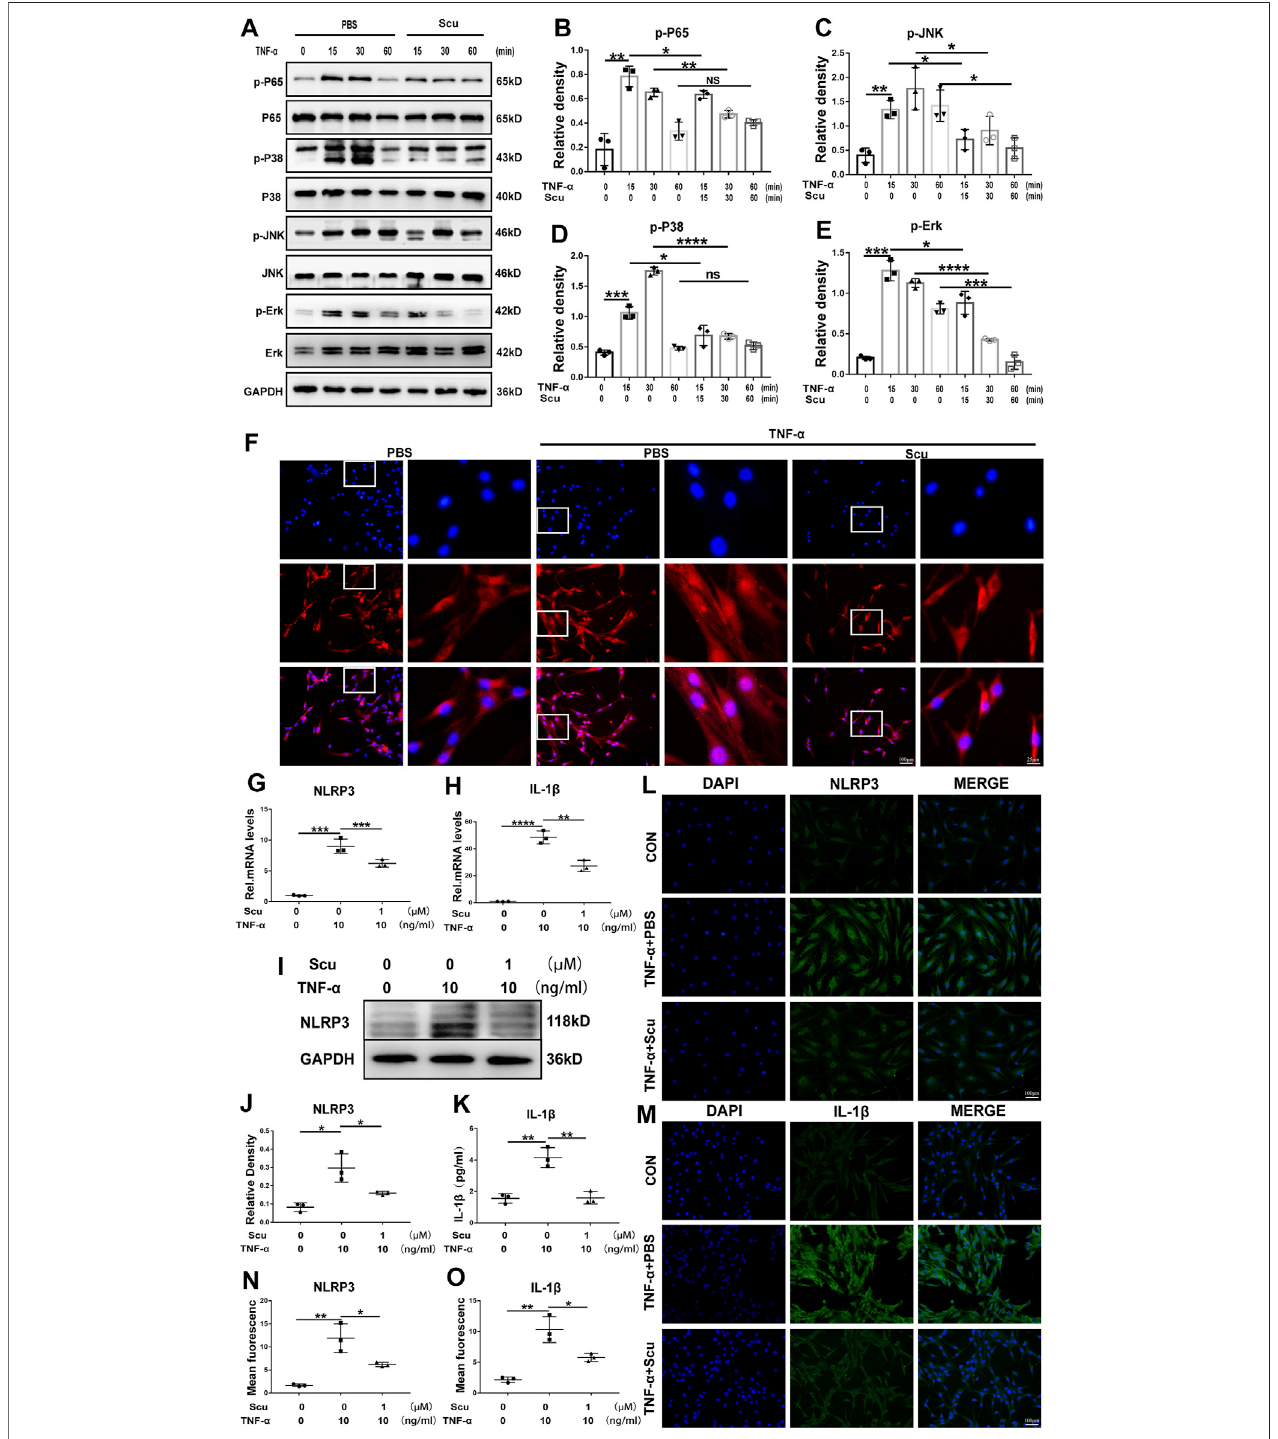
FIGURE 7 | Scutellarin inhibited the NF- κ B/MAPK signaling pathways and suppressed activation of the NLRP3 in fl ammasome in HNPCs. (A – E) HNPCs were treated with PBS, TNF- α (10 ng/ml), TNF- α (10 ng/ml) +scutellarin (1 μ M) for 15 min, 30 min, and 1 h. Total protein was extracted, and the levels of p-p65, p65, p-p38, p38,p-JNK,JNK,p-ERK,andERKweredetectedbyWesternblotting. (F) Nucleartranslocationofp65inHNPCs,whichweretreatedasindicatedfor6 h,wasassayed through immuno fl uorescence staining (scale bar: 100 μ m or 25 μ m). (G,H) After culturing as indicated for 24 h, the mRNA expression of NLRP3 and IL-1 β in each group was detected by real-time PCR. (I,J) Western blotting was performed to assay the protein levels of NLRP3 in each group treated for 48 h as indicated. (K) IL-1 β secretion levels of each indicated group were detected by ELISA. (L – O) The expression levels of NLRP3 and IL-1 β in HNPCs in the indicated groups were examined by immuno fl uorescence staining (scale bar: 100 μ m). Each experiment was performed three times independently. (* p < 0.05, ** p < 0.01, *** p < 0.001, **** p < 0.0001).